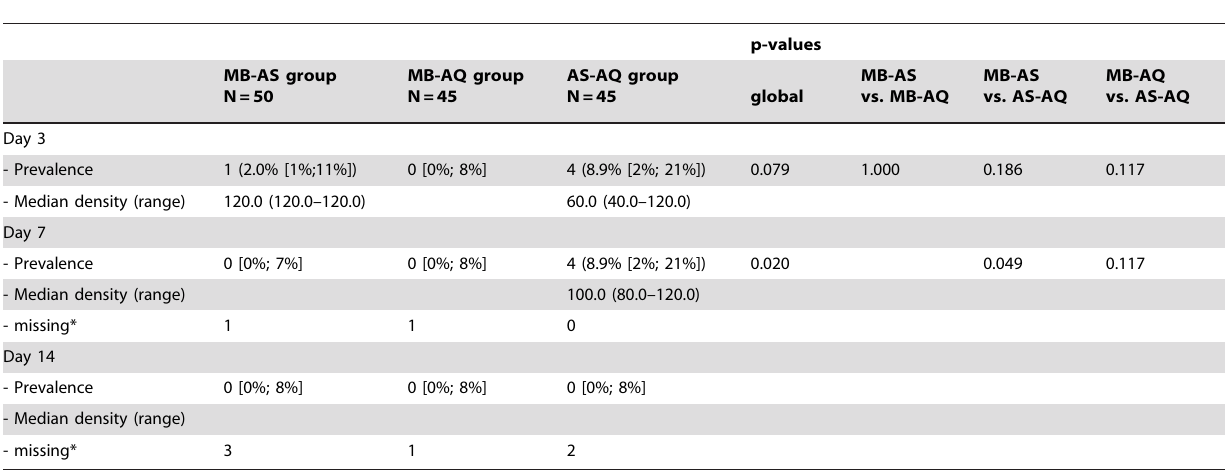
Table 4. Efficacy of the study drugs against P. falciparum gametocytaemia after exclusion of all cases with gametocytes on day 0 and/or day